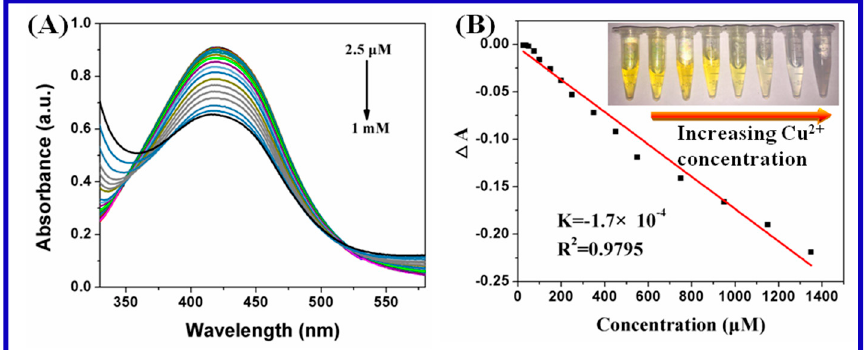
Figure 6. ( A ) UV-Vis absorption spectral of carrageenan-AgNPs with various amounts of Cu 2+ . ( B ) The plot of relative absorption intensity ( Δ A) vs. different concentrations of Cu 2+ .